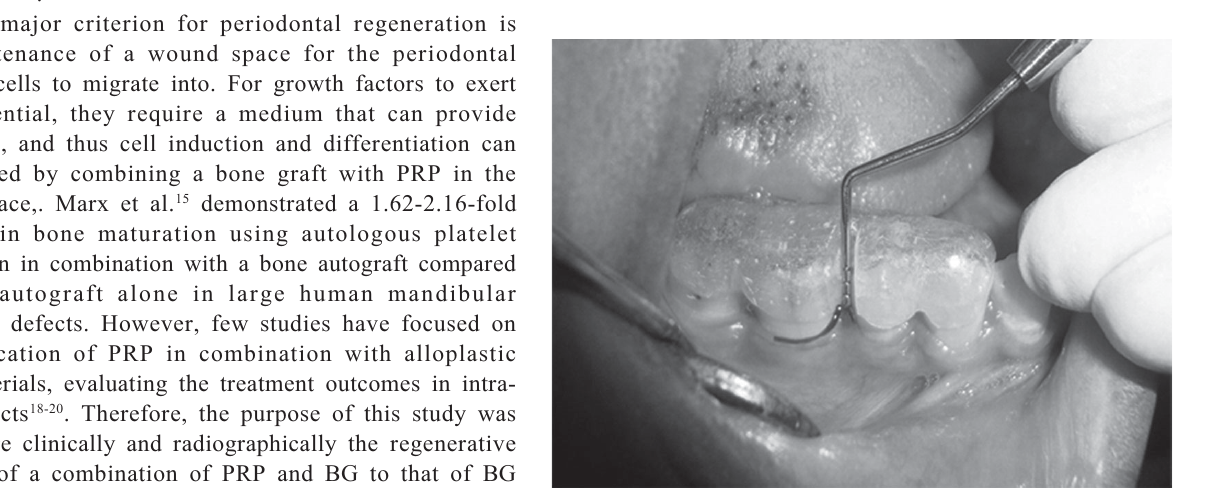
Fig. 1. Customized acrylic stent with guiding